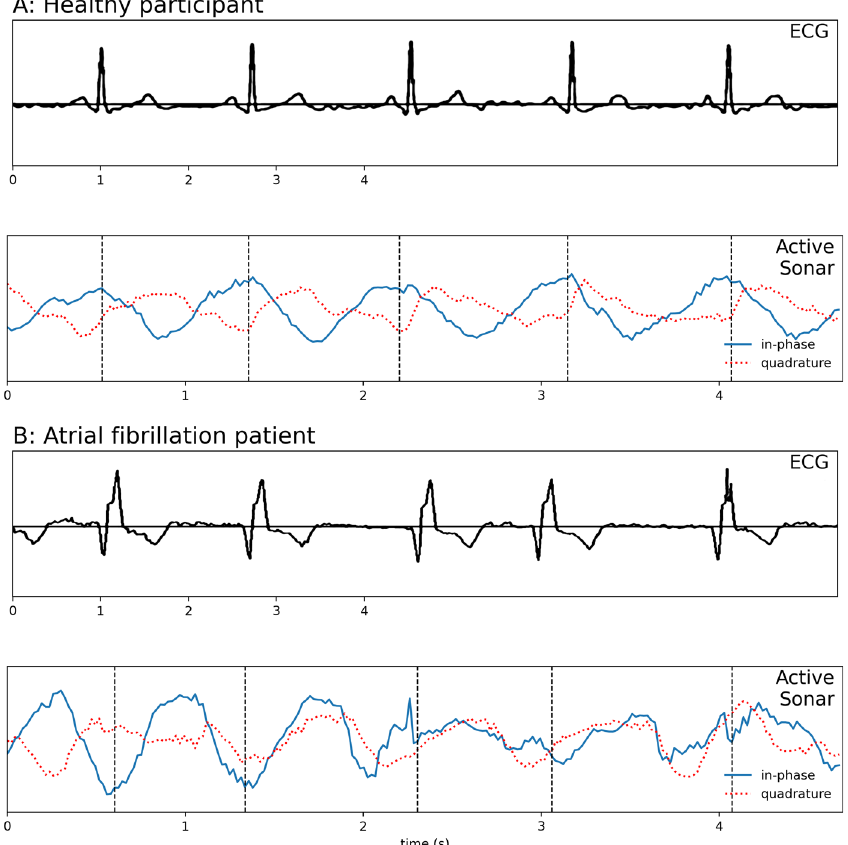
Fig. 2 Example heart rhythm waveforms extracted by our system along the ground truth ECG waveforms. The acoustic waveforms include both in-phase and quadrature-phase components after beamforming. The cardiac rhythm signal shifts between the in-phase and quadrature-phase components due to residual respiration motion that remains after beamforming. The vertical dotted lines show the segments computed by the segmentation algorithm, which combines data from both in-phase and quadrature-phase components. The fi gure shows the waveforms for a A healthy participant and B atrial fi brillation